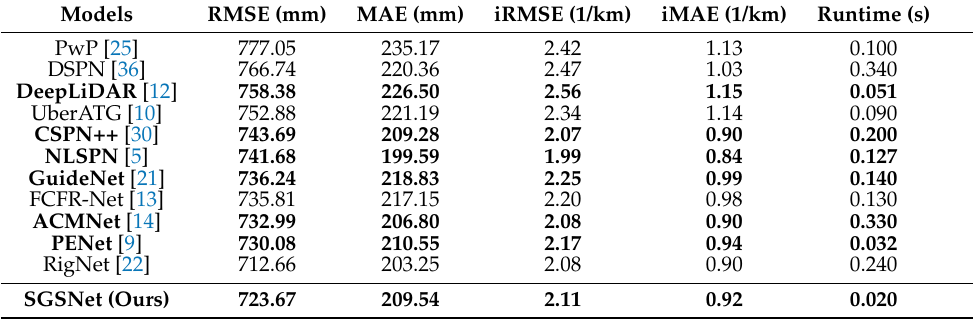
Figure 7. Comparison with the KITTI depth completion test set with state-of-the-art methods, including ( b ) PENet, ( c ) ACMNet, ( d ) GuideNet, and ( e ) CSPN++, where ( a ) is the input RGB image, and ( f ) is the output of our proposed model. As shown by some details, our proposed module has better edge detail features. Table 3. Comparisons to state-of-the-art methods on the KITTI test